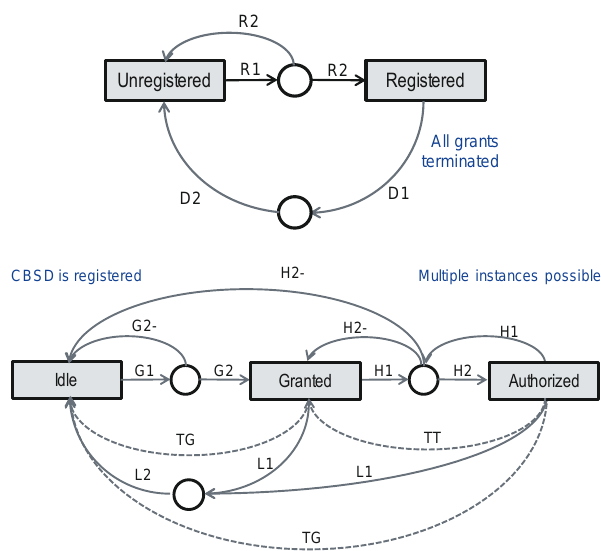
Figure 4. State diagrams for the CBRS Registration/Deregistration and Grant state.